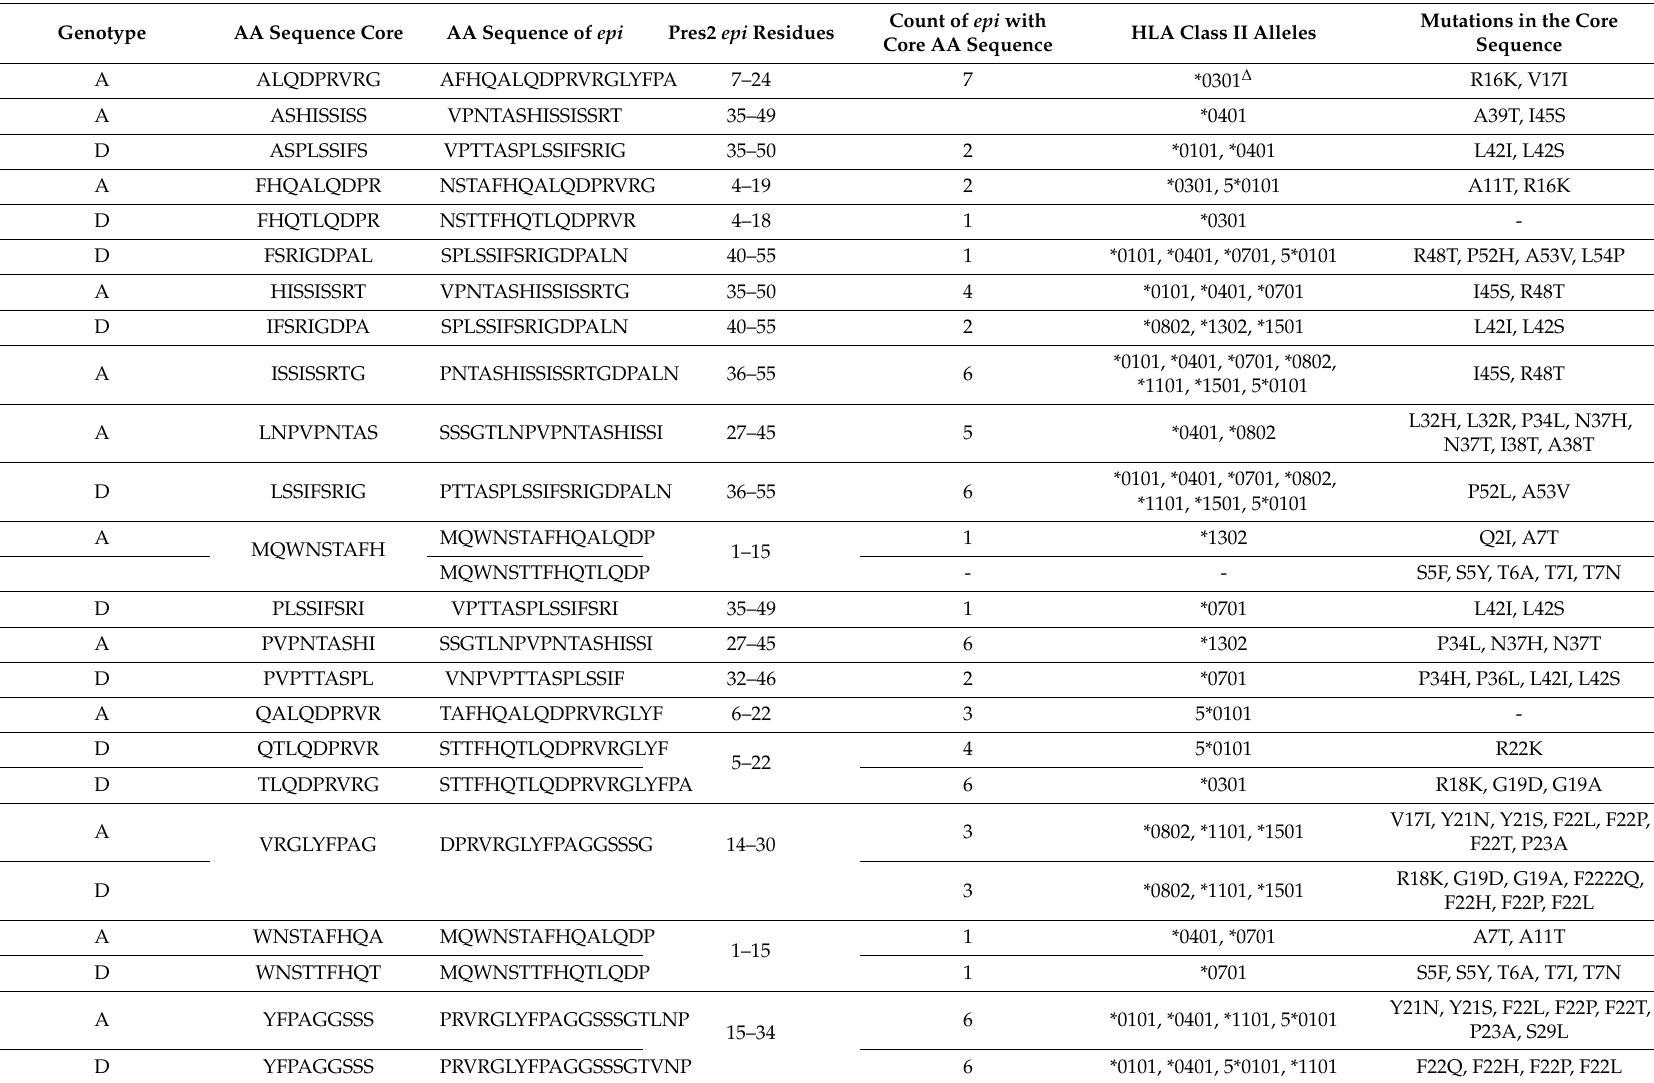
Table 7. Summary of PreS2 epitopes binding to respective alleles, and mutations that exist within the Botswana HBV